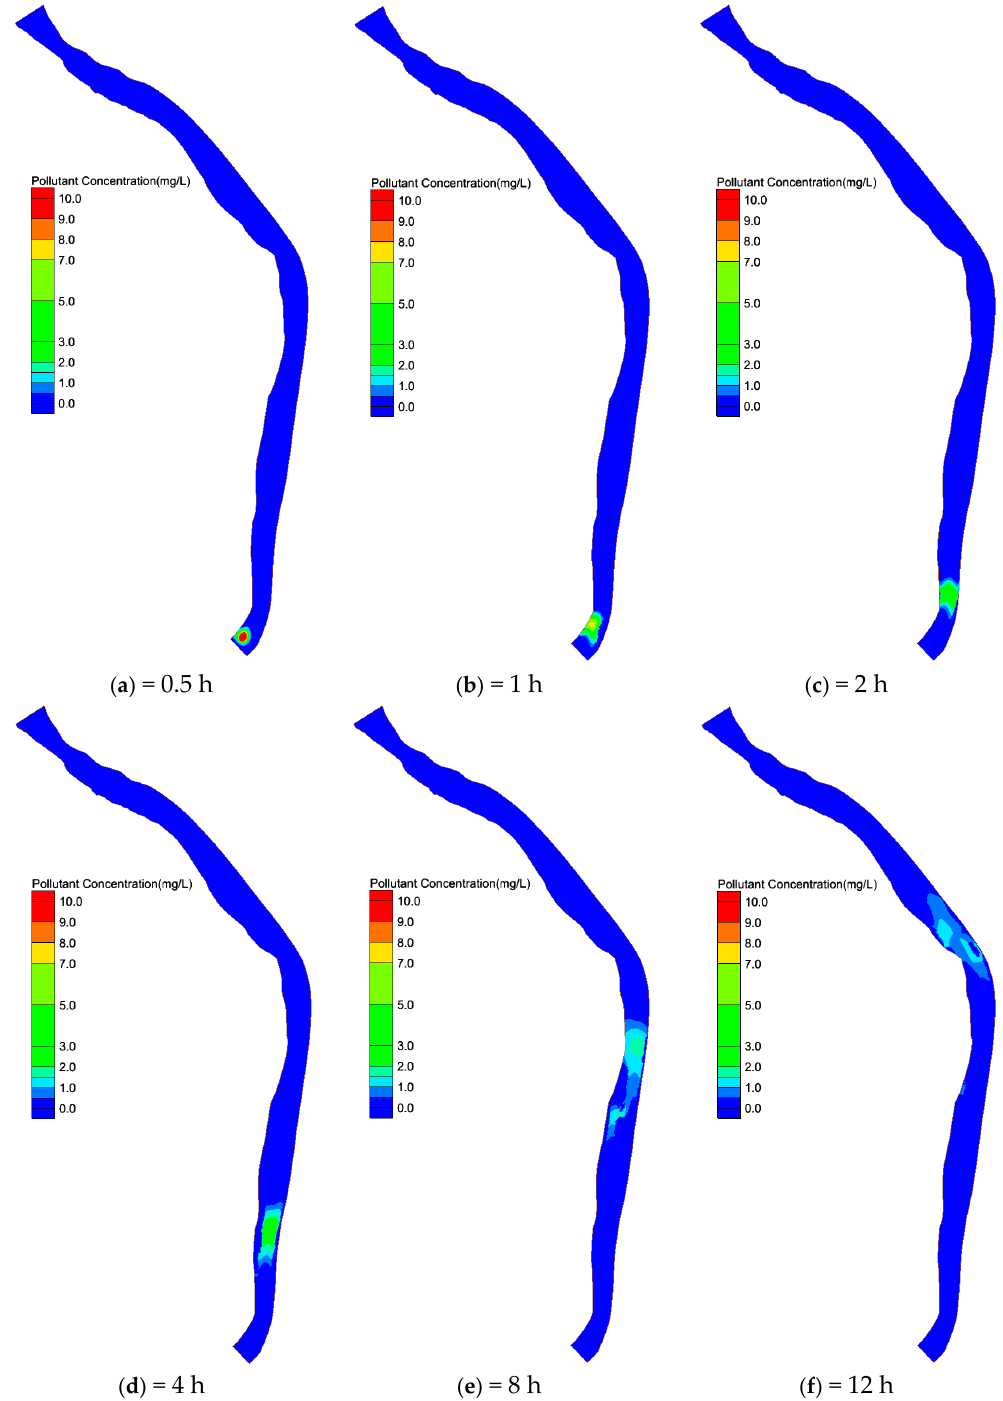
Figure 5. Pollution diffusion dynamics after the occurrence of the water pollution accident under Scenario D (Q = 2400 m 3 /s, H = 25.12 m).